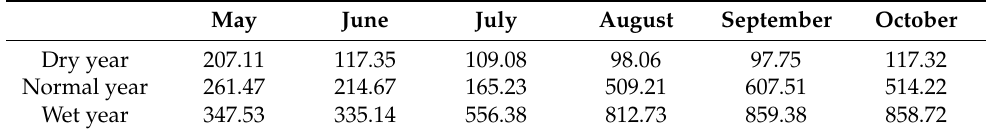
Table 1. Changes in surface water extent (SWE, km 2 ) of the top 10 largest connectomes in the Momoge National Nature Reserve, China during dry, normal, and wet